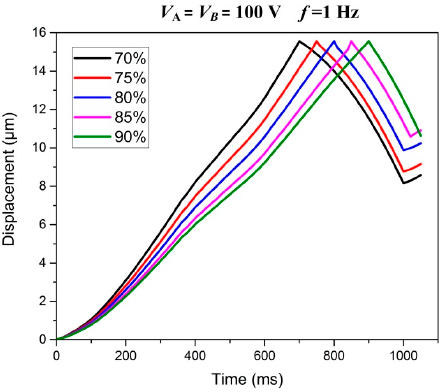
Figure 14. Displacement of the slider in a working circle with different percentages of stacks’ charging time.